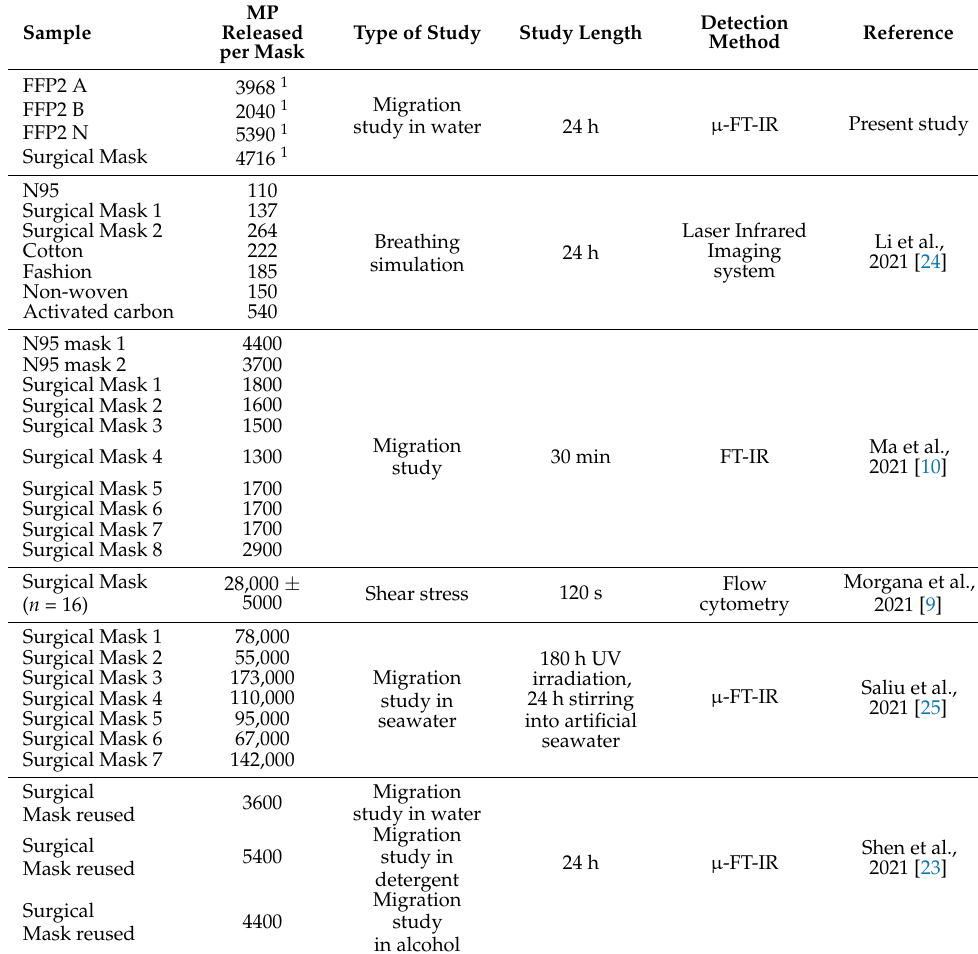
Table 5. Number of MP released from face masks according in this study and comparison to previous